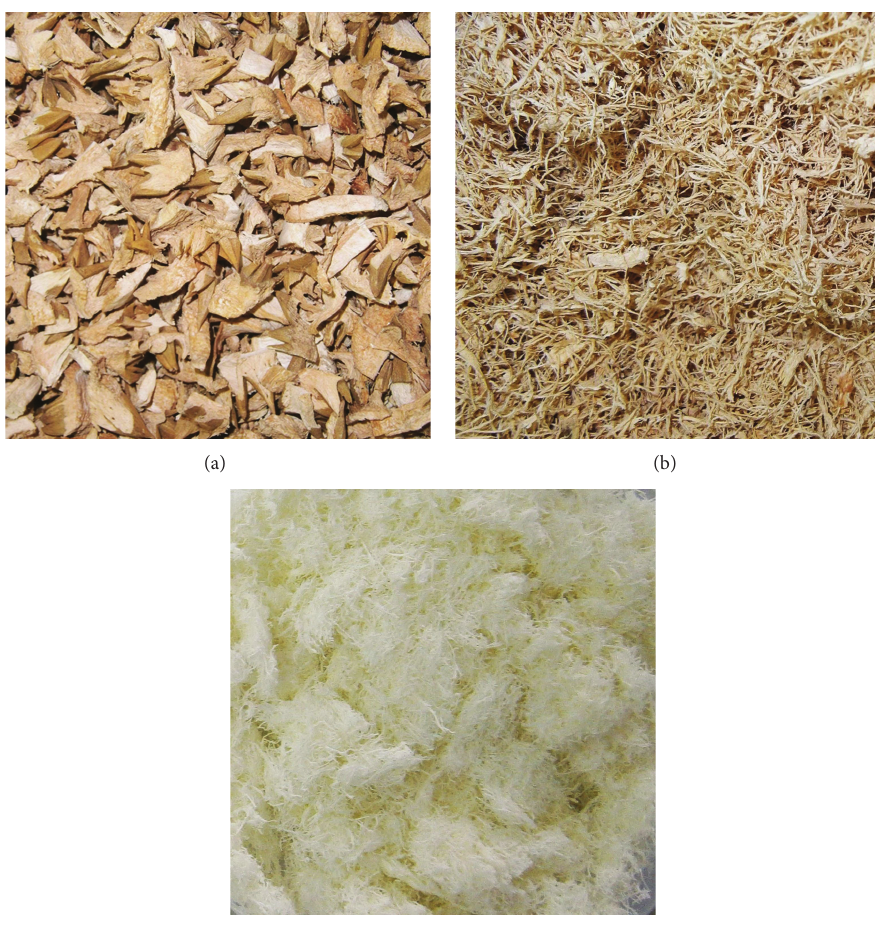
Figure 1: Macroscopic image of (a) durian peel, (b) ground durian peel, and (c)